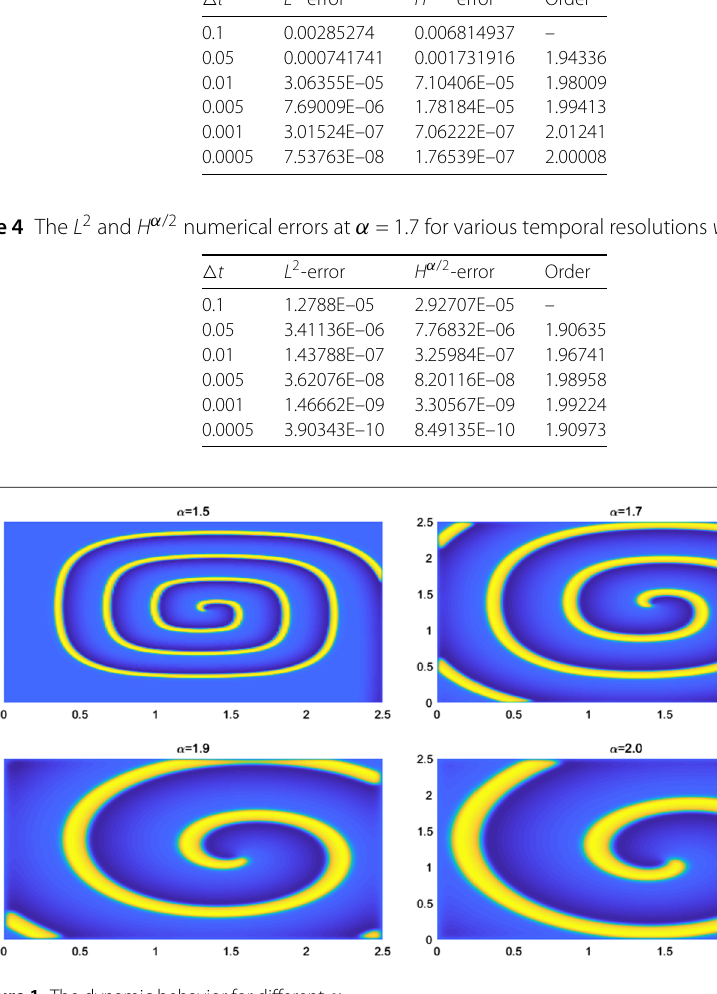
Figure 1 The dynamic behavior for different